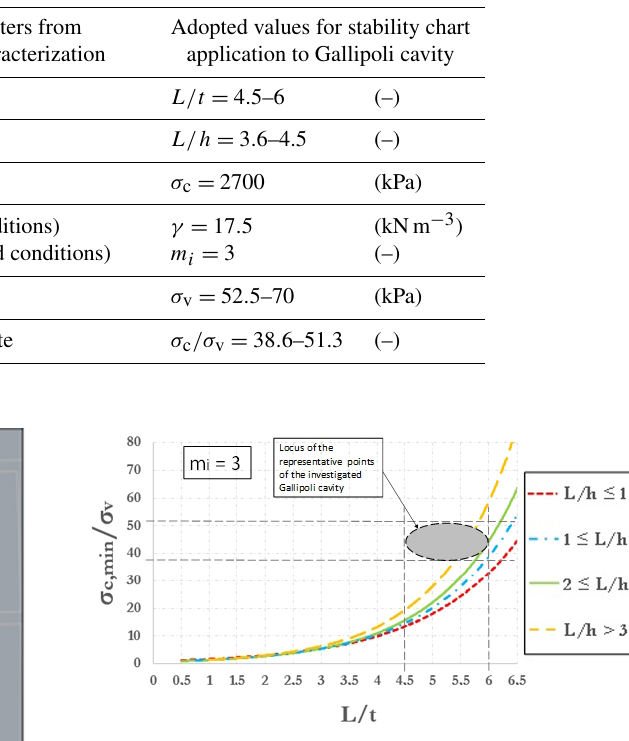
Figure 17. Application of stability chart ( m i = 3) for the Gallipoli underground